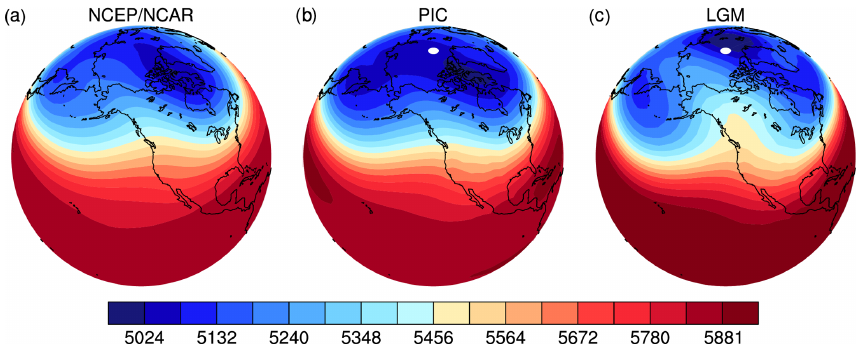
Figure 8. Climatological mean 500hPa geopotential heights in DJF in NCEP/NCAR reanalysis and PMIP2 CCSM3 simulations. (a) NCEP/NCAR, (b) PIC and (c) LGM. The height unit is